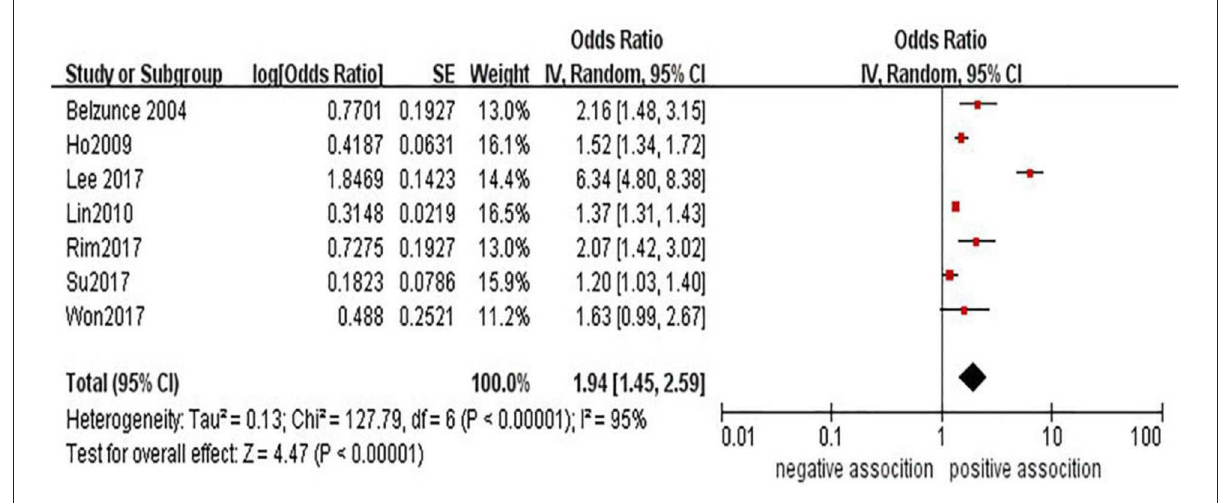
FIGURE2 Forest plot of evaluating the association between glaucoma and